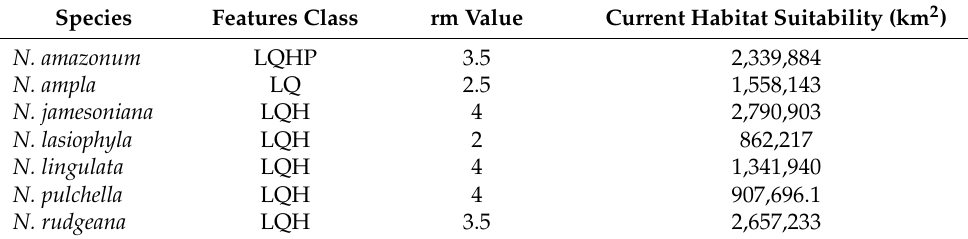
Table 2. Feature classes selected for the modeling of the Nymphaea species in South America. The abbreviations represent linear (L), quadratic (Q), hinge (H), and product (P) at varying regularization multiplier (rm) values.